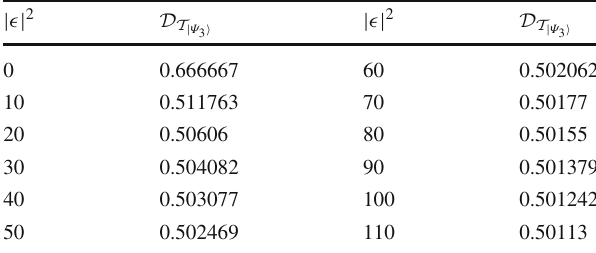
Table 6 Numerical values of dimensionless parameter in | Ψ 3 (cid:3) state for associated coherent parameter | (cid:11) |